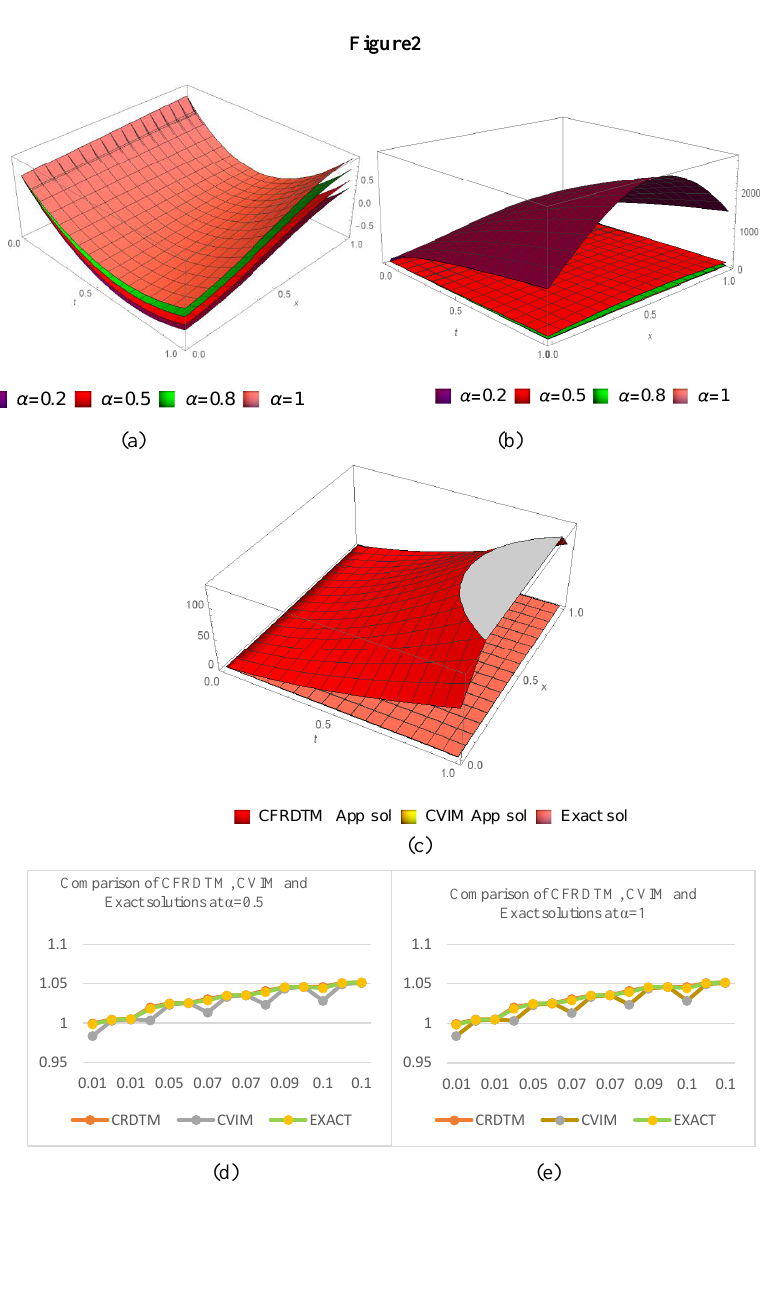
Figure 2: Approximate solution for the time-fractional Gardner Eq. (32 ) for different values of α with fixed values 0 ≤ t ≤ 1, 0 ≤ x ≤